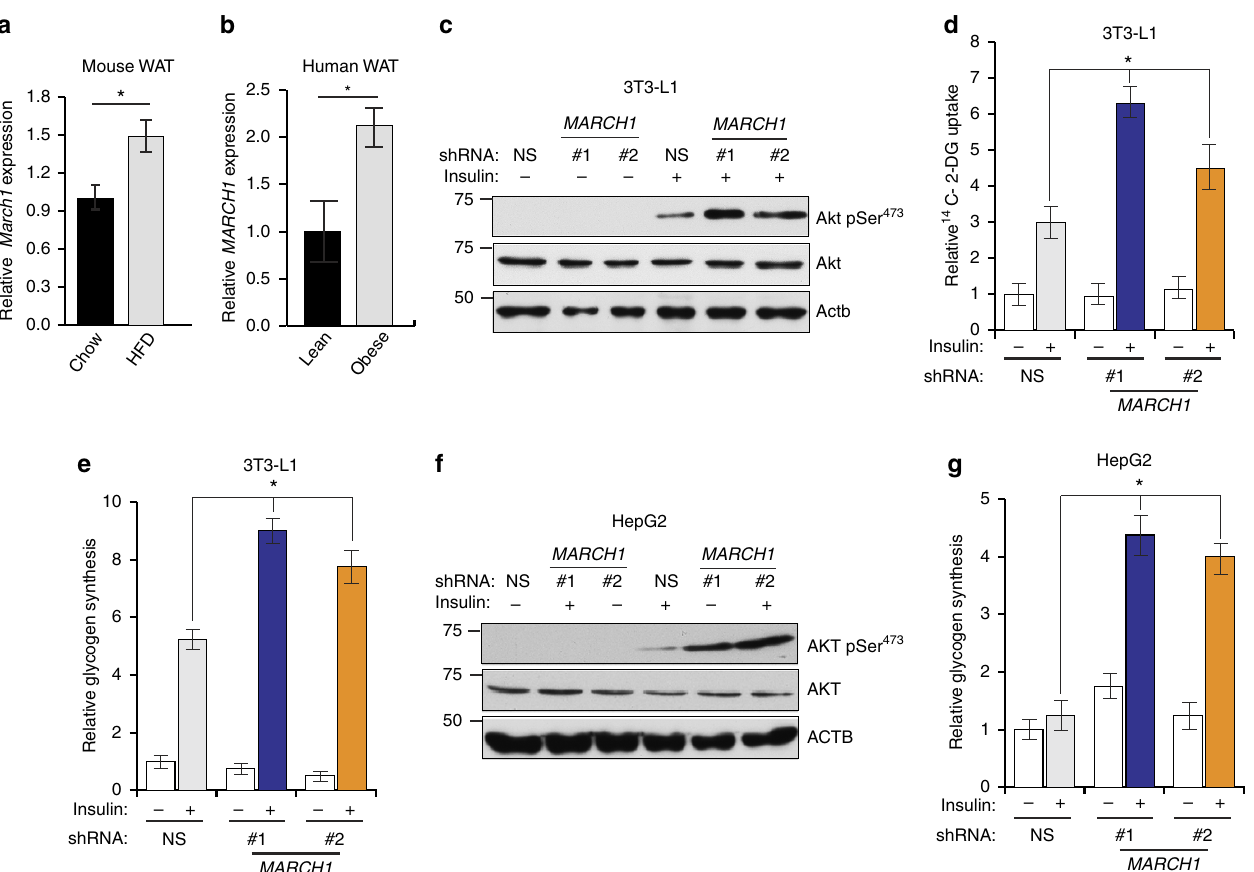
Figure 2 | MARCH1 expression is increased in WAT from obese humans and mice and regulates insulin signalling in target tissues. ( a ) qRT-PCR measurement of March1 expression in WATof adult male C57BL/6J mice fed either regular chow or high-fat diet. ( b ) qRT-PCR measurement of MARCH1 expression in WAT from lean ( n ¼ 8) and obese ( n ¼ 13) human adolescent subjects. ( c ) Immunoblot analysis of AKT Ser 473 phosphorylation in differentiated 3T3-L1 adipocytes expressing indicated shRNAs. ( d ) Relative 14 C-2-deoxyglucose uptake ( n ¼ 4) in differentiated 3T3-L1 adipocytes expressing either NS or March1 shRNA. ( e ) Relative glycogen synthesis ( n ¼ 3) in differentiated 3T3-L1 adipocytes expressing either NS or March1 shRNA. ( f ) Immunoblot analysis of AKT Ser 473 phosphorylation in HepG2 hepatocytes expressing either NS or MARCH1 shRNA. ( g ) Relative glycogen synthesis ( n ¼ 3) in HepG2 hepatocytes expressing either NS or MARCH1 shRNA. In d , e , g , *compares NS and MARCH1 shRNAs in presence of insulin. In all panels, data are mean ± s.e.m. and * P o 0.05, comparisons by t -test. qRT-PCR, quantitative real-time